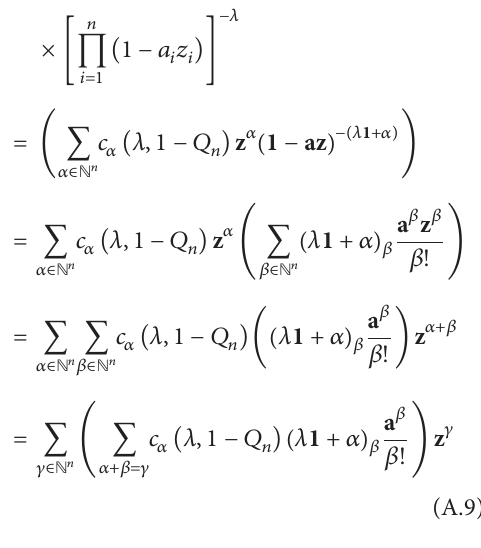
Figure 7: Real-world polarimetric intensity images of a scene composed of a plastic disk (left) and a steel disk (right).